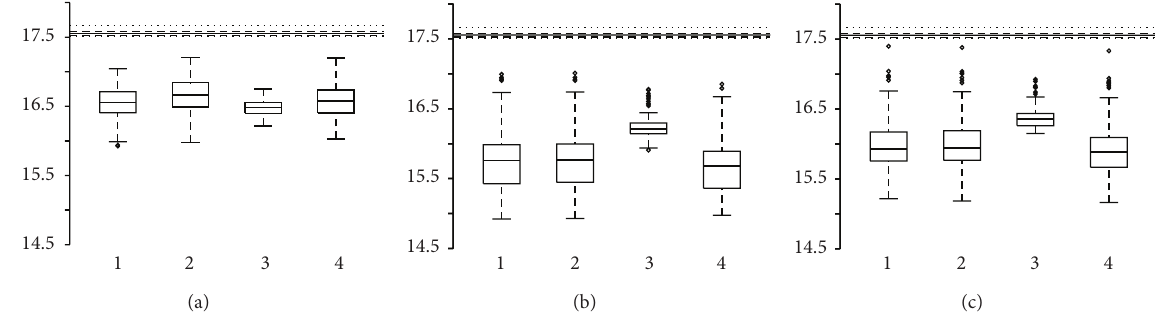
Figure 5: Boxplots of the 100 RMSE of the models predicting organic layer thickness. (a) 10 m terrain resolution, (b) 20 m terrain resolution, and (c) 30 m terrain resolution. 1 = default Random Forest parameters, 2 = additional predictor selection, 3 = 1, 2+ tuning of sampsize, and 4 = 1, 2+ tuning of mtry. The lines refer to the boxplot parameters of the RMSE distribution of the mean of the data as prediction model. Solid line: median, dashed line: upper/lower hinges, and dotted line: upper/lower